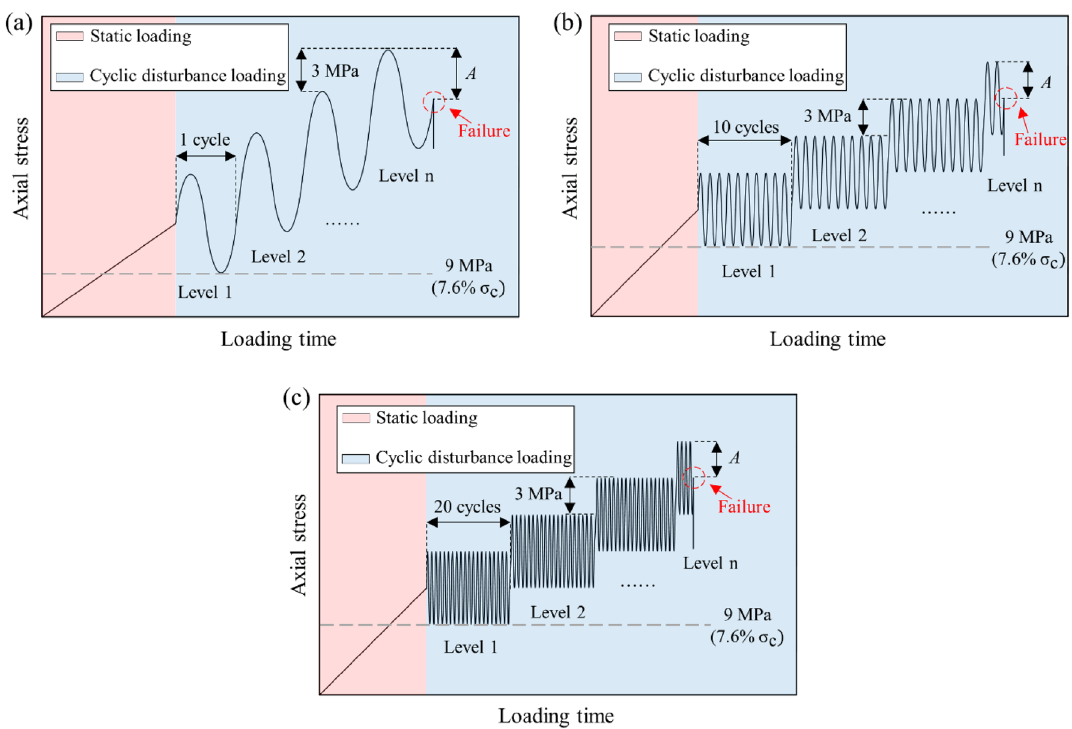
Figure 4. Schematic diagram of loading paths ( a ) Path in N = 1; ( b ) Path in N = 10; ( c ) Path in N =